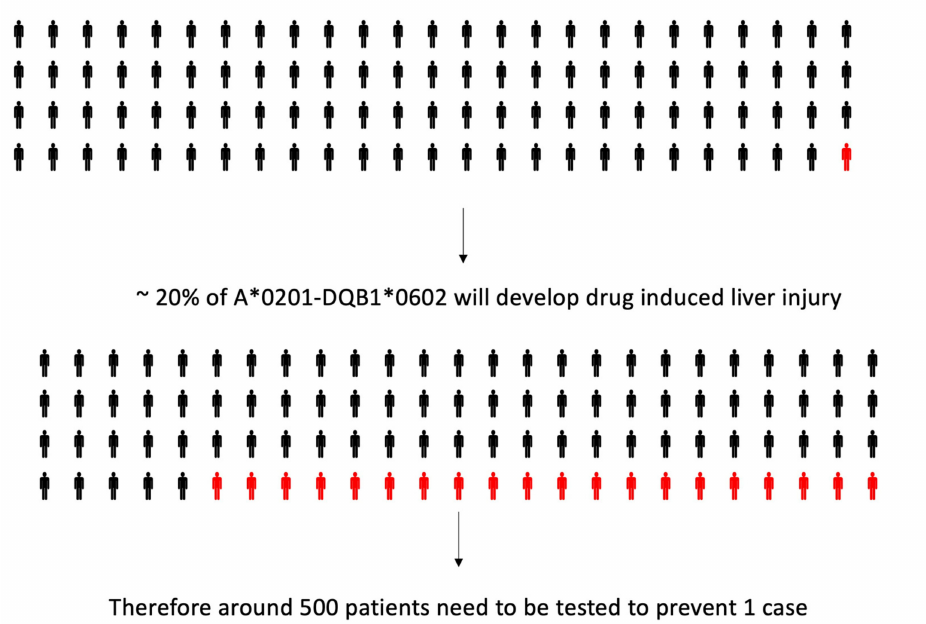
Figure 2. Limited positive predictive value of human leukocyte antigen (HLA) risk alleles for amoxicillin- clavulanate-induced liver injury: on the basis of data published by Lucena and colleagues